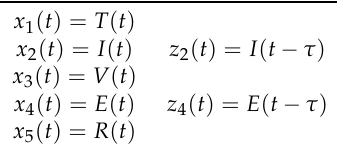
Figure 4. Relative sensitivity curves ξ (solid line), ξ = b 2 (dashed line) (right). The parameters and initial conditions are as in Figure 3.